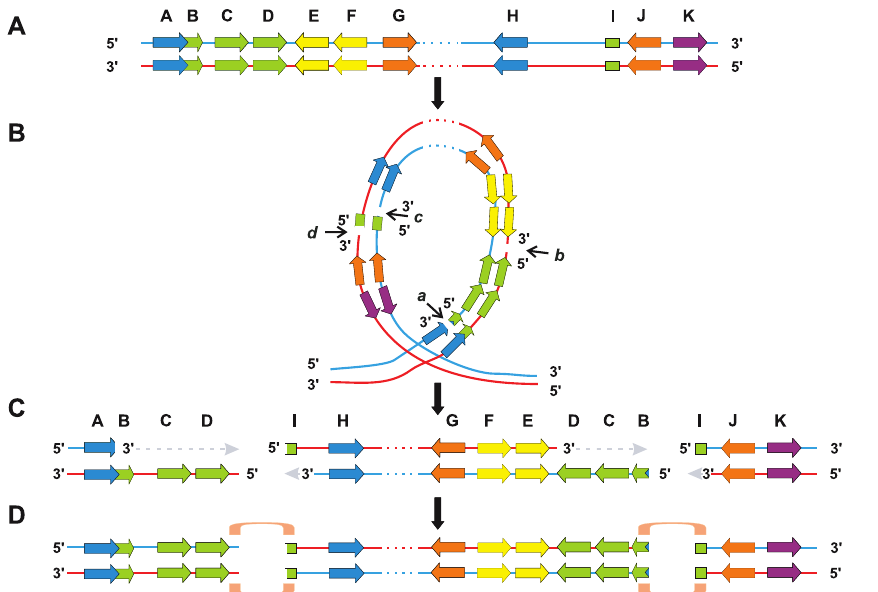
Figure 2. An Isochromatid Model with Staggered Single-Strand Breaks Can Give Rise to an Inversion Accompanied by Duplications at the Breakpoint Regions in Inverted Orientation The mechanism is illustrated in relation to the inversion 3R(8), which is fixed in the lineage to D. melanogaster . (A) Ancestral state in D. simulans (Figure 1). (B) Two pairs of staggered single-strand breaks (a-b and c-d) result in long 5 9 -overhangs (C), which can then be filled in (grey dashed arrow); when followed by nonhomologous end joining, this may result in an inversion flanked by inverted duplications of the sequences between the paired single- strand breaks (D). Landmarks: A, CG2708; B, HDC14862 (3 9 ); C, pfd800; D, HDC12400; E, HDC14861; F, HDC14861; G, CG31176; H, CG7918; I, HDC14862 (5 9 ); J, CG34034; and K, CG5849 . Color code as in Figure 1. Figure S2 illustrates the model for the formation of the inversion 3R(7).